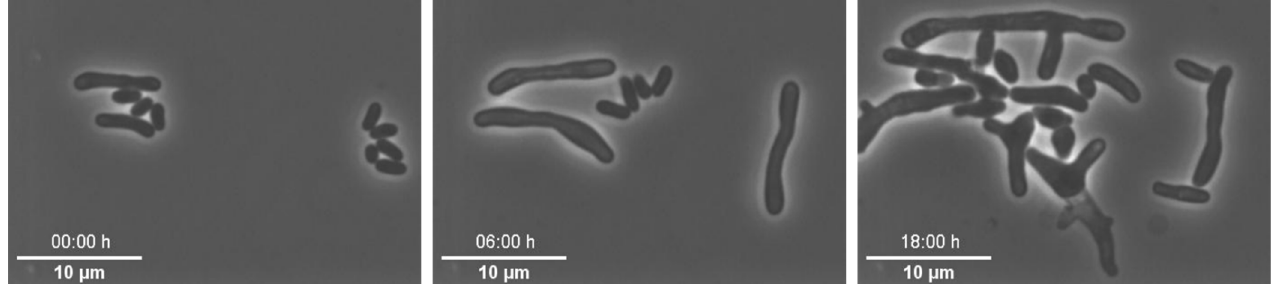
Figure 8. Microscopic images of C. glutamicum in which the morphology of the cells was already different at the beginning of cultivation and had changed further in the course of cultivation (scale bar = 10 μ m).